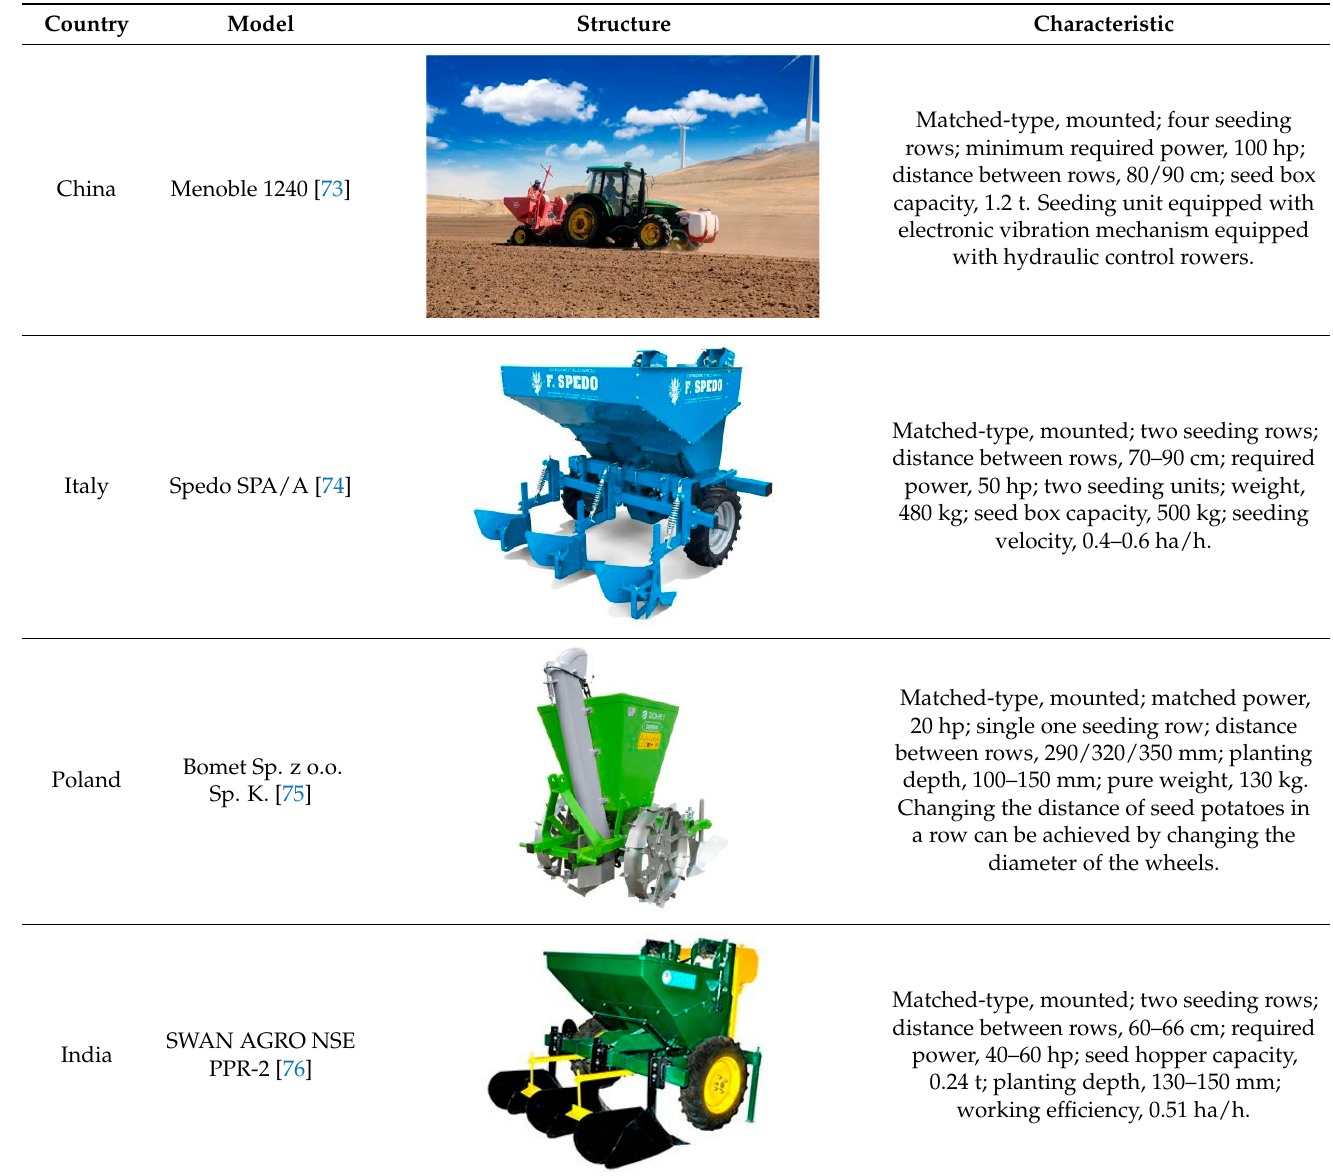
Table 6. Introduction of belt-type potato planters.